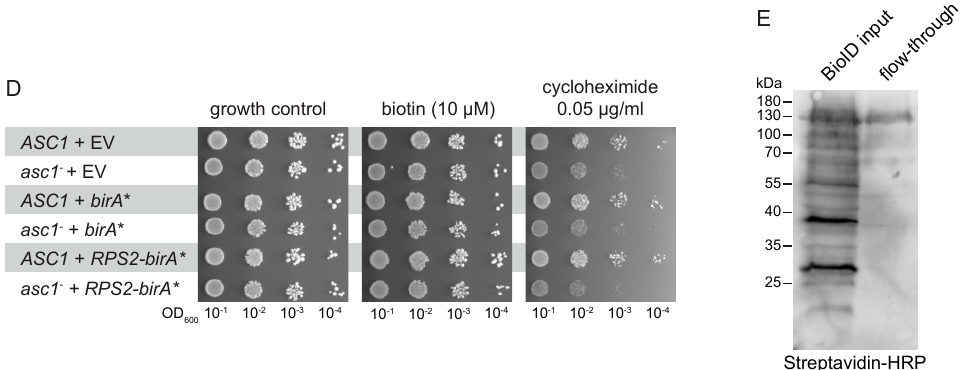
Figure 1. Set-up of the Rps2-BioID analysis. ( A ) Rps2-BirA* at the hr40S in the presence and absence of Asc1 (red). The BirA* protein (dark green) is fused to the C-terminus of Rps2 (uS5, orange) with a linker sequence consisting of four repeats of Gly-Ser-Ser (GSS). The last four amino acids of Rps2 (in orange letters) were structurally not resolved and are indicated within an orange arrow. Ribosomal proteins captured with Rps2-BirA* are highlighted in di ff erent colors: Rps17 (eS17) yellow, Rps3 (uS3) light green, Stm1 blue. Biotinylated lysine residues K212 and K223 of Rps3 are indicated with green asterisks (the green arrow indicates the last 15 C-terminal amino acids of Rps3 that were structurally not resolved). The PyMOL Molecular Graphics System software was used to generate the figures from crystal structure data of the S. cerevisiae 80S ribosome and the E. coli BirA protein derived from the PDB entries 4V88 [15] and 1BIB [45], respectively. ( B ) An aliquot of each SILAC-labeled culture was taken prior to cell pooling for cell lysis. Extracts were applied to SDS-PAGE and proteins blotted to a membrane. Streptavidin-HRP was used to detect biotinylated proteins (left), and a BirA-specific antibody was applied to detect the BirA* and Rps2-BirA* proteins (right). The birA* and RPS2-birA* alleles were expressed from extrachromosomal high copy number plasmids in the ASC1 wild-type and asc1 − background as indicated. Ponceau staining of the proteins on the membrane served as the loading control. Results are shown representatively for one of three replicates. ( C ) Strategy and workflow of the Biotin IDentification (BioID) experiment. Stable isotope labeling with amino acids in cell (SILAC) amino acids were used for a triple-labeling approach with three replicates (I-III), including a medium to heavy label swap. For detailed information about mass-spectrometry data acquisition (XCalibur) and analysis (MaxQuant and Perseus), see Materials and Methods and Table 3. ( D ) Drop dilution assays (successive 10-fold dilutions) in the presence of biotin or cycloheximide to test whether the additional expression of BirA* or Rps2-BirA* impairs colony growth. Strains transformed with the empty vector (EV) were used for growth controls. ( E ) Binding of biotinylated proteins on Strep-Tactin gravity flow columns. Equal volumes of the cell lysate (BioID input, applied on the Strep-Tactin column) and the flow-through were subjected to SDS-PAGE and proteins blotted to a membrane followed by detection of biotinylated proteins using streptavidin-HRP.